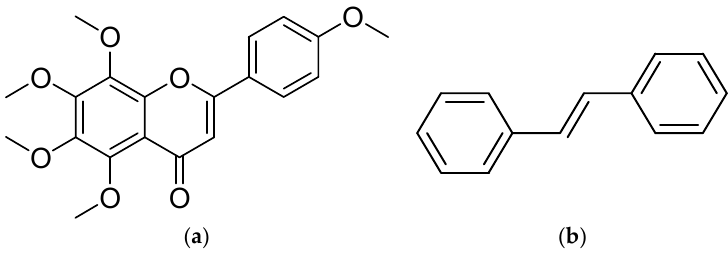
Figure 1. Chemical structures of: ( a ) Tangeretin; ( b ) trans -Stilbene (internal standard).